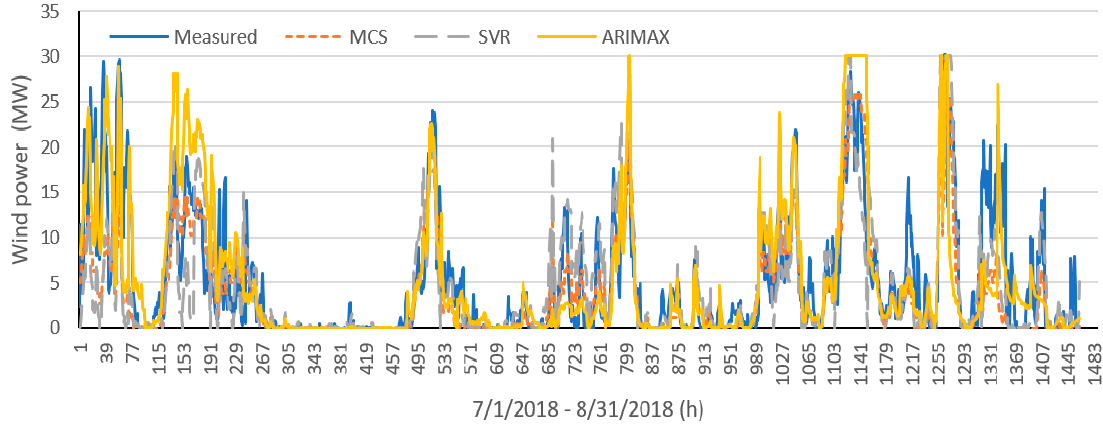
Figure 6. Forecast results of single models results (the x axis represents the 1 h intervals time for the forecast period). Table 3. Accuracy of single models for two months.